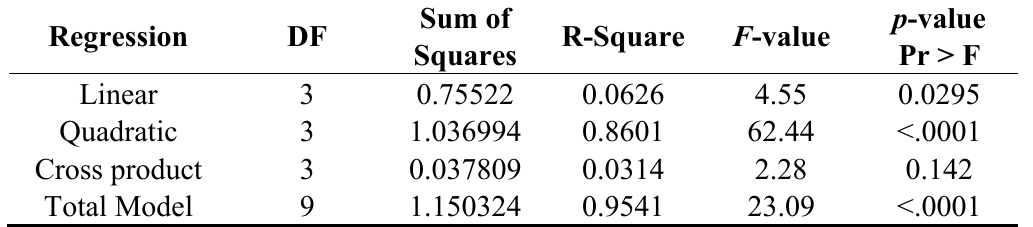
Table 3. Variance analysis of the second-order regression model on extraction